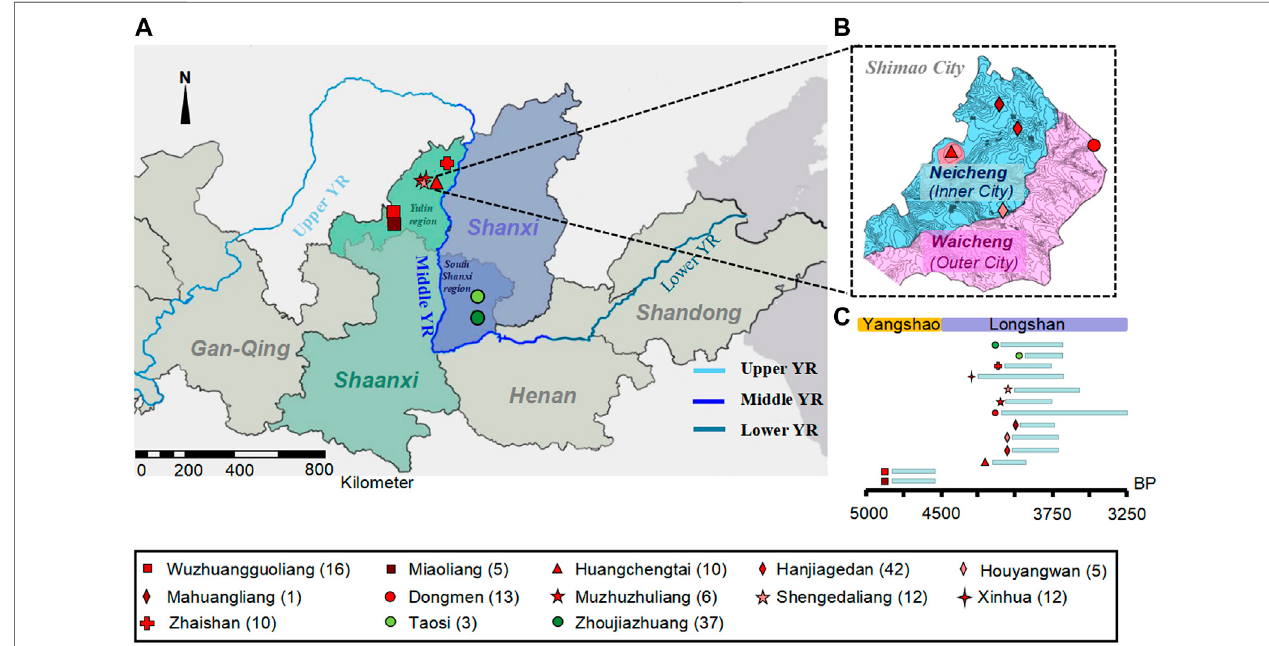
FIGURE 1 | The geographical and temporal distributions of the new samples. (A) The geographical location of ancient individuals from 13 archaeological sites in northern Shaanxi and southern Shanxi Province of Middle YR. The different colored and shaped labels represent different sites. The dark red represents those from the MN Yangshao sites, and red represents Shimao-related populations in and neighboring Shimao City in LN Longshan period in northern Shaanxi Province; green represents the Taosi-related populations in southern Shanxi Province. (B) The geographical distribution of ancient individuals in Shimao City. (C) Timeline of archaeological